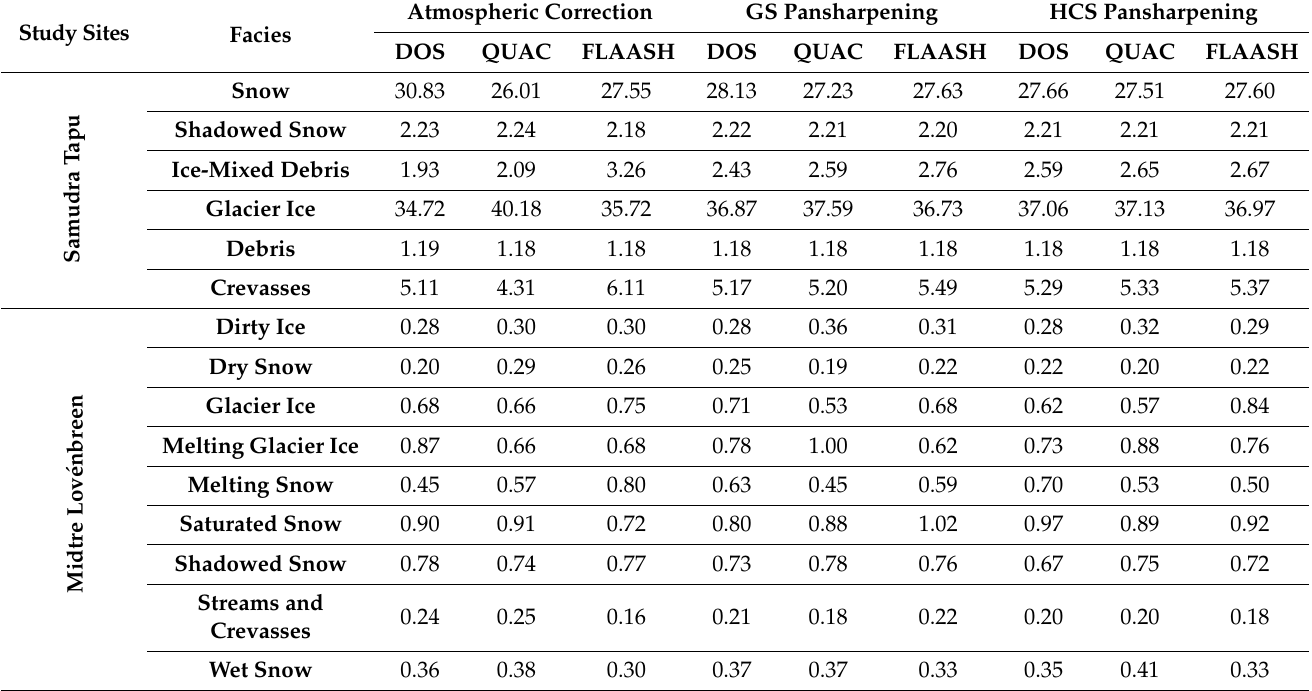
Table 4. Classified area of facies for each processing scheme for the glaciers ST and ML averaged across all rule sets are summarized